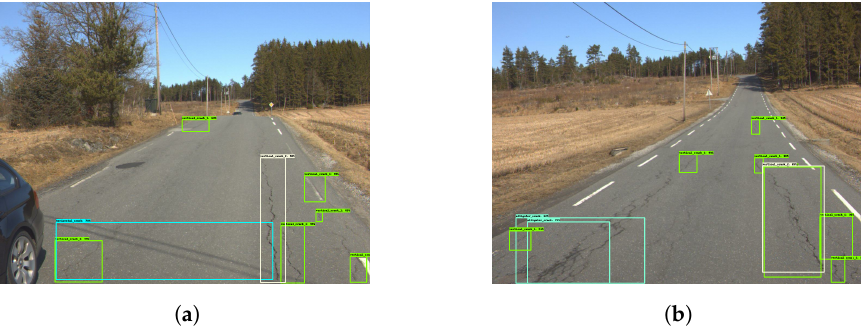
Figure 14. Poor damage detection—Model 3. The green and yellow boxes represent the vertical cracks while cyan colored boxes are the horizontal